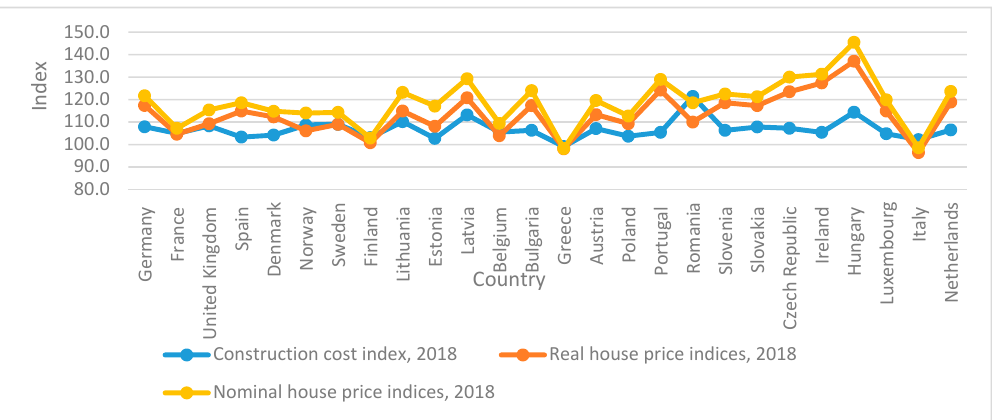
Figure 9. The correlations between the construction cost indices and real house price (nominal house price) indicators of the 25 EU countries, the UK and Norway (data for 2018).